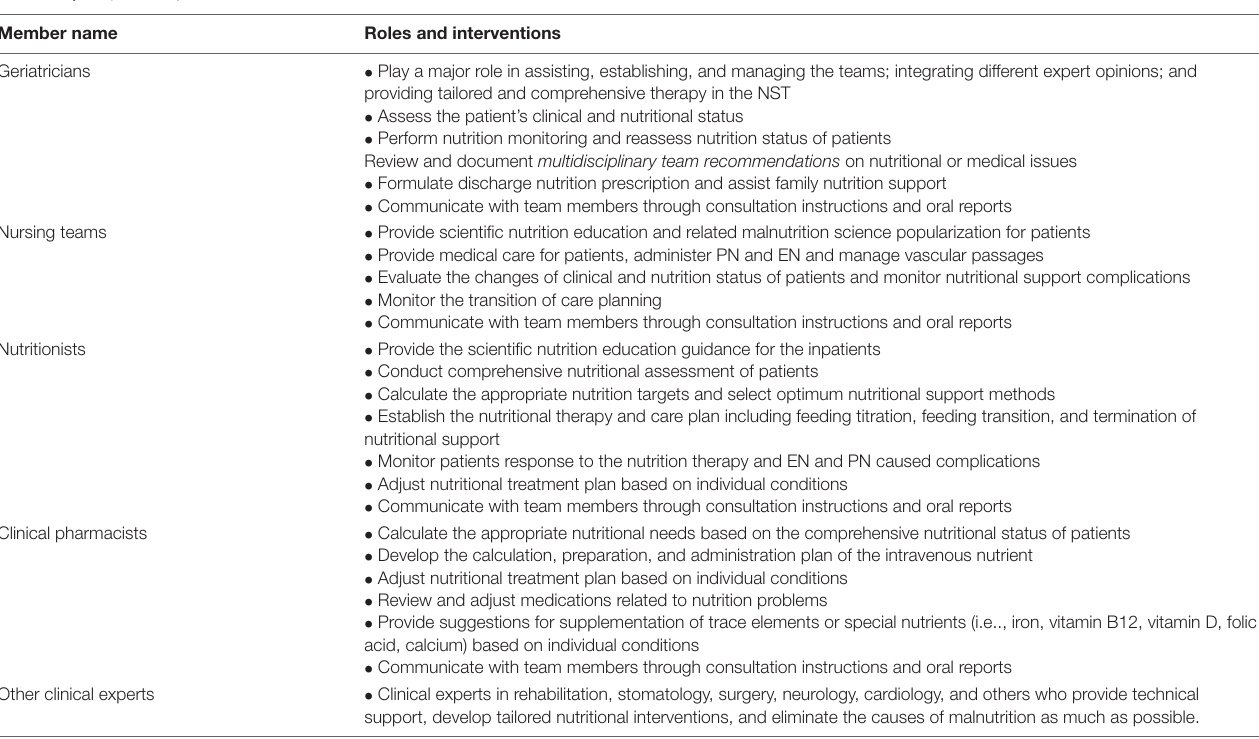
FIGURE 2 | The clinical treatment model of nutrition support team (NST) to provide the tailored optimum nutritional intervention in malnourished aged patients based on multidisciplinary team recommendations. TABLE 2 | Responsibility and interventions of members of